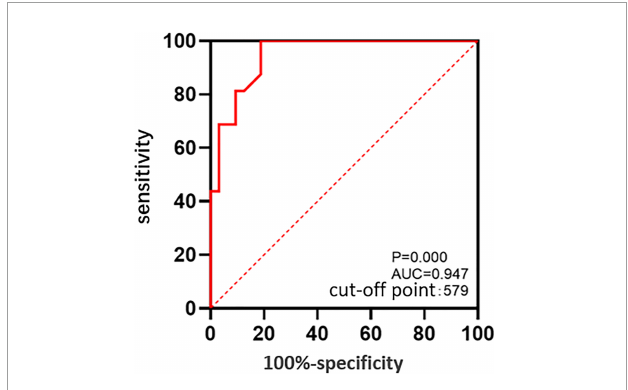
FIGURE3 The ROC curve: The predictive value of the MD for postoperative reconstruction states of